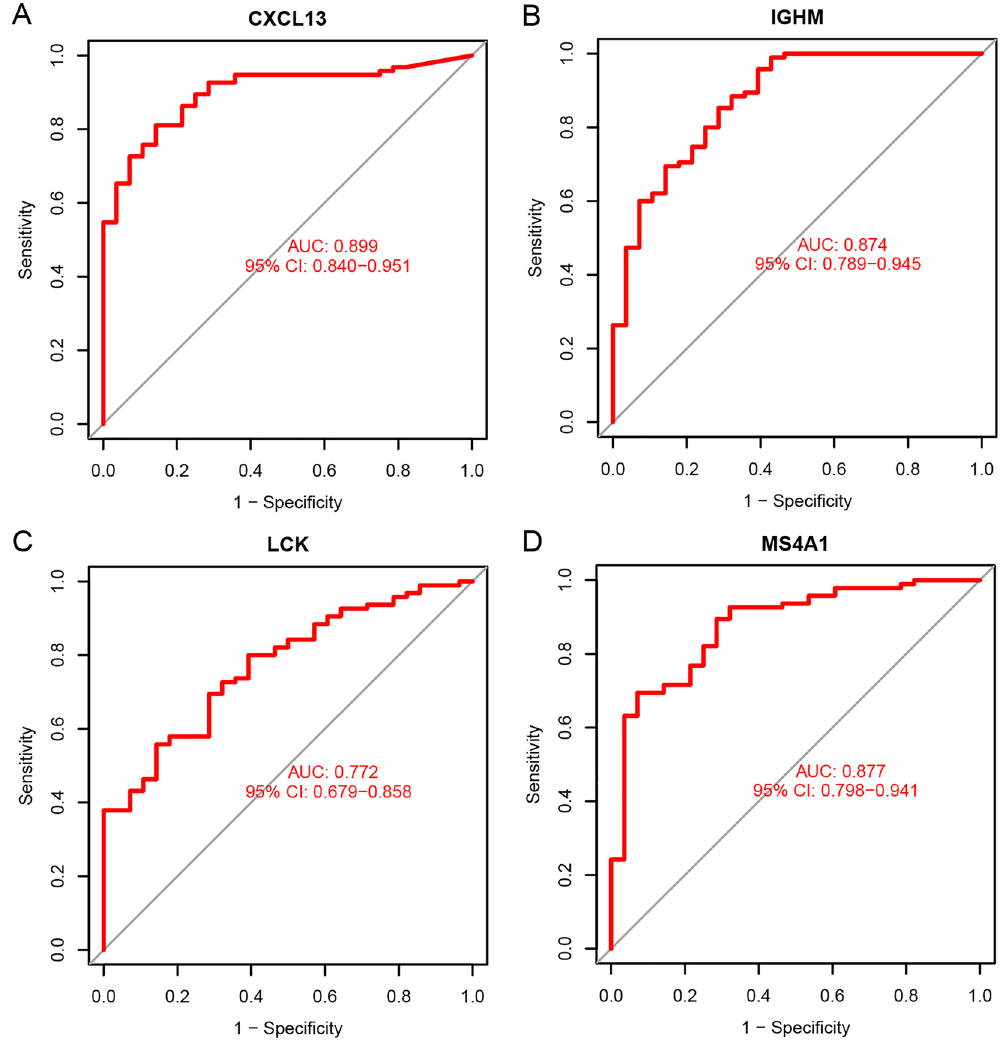
Figure 5. ROC curve analysis in the validation cohort. ( A ) ROC curves of the expression of CXCL13 to predict RA. ( B ) ROC curves of the expression of IGHM to predict RA. ( C ) ROC curves of the expression of LCK to predict RA. ( D ) ROC curves of the expression of MS4A1 to predict